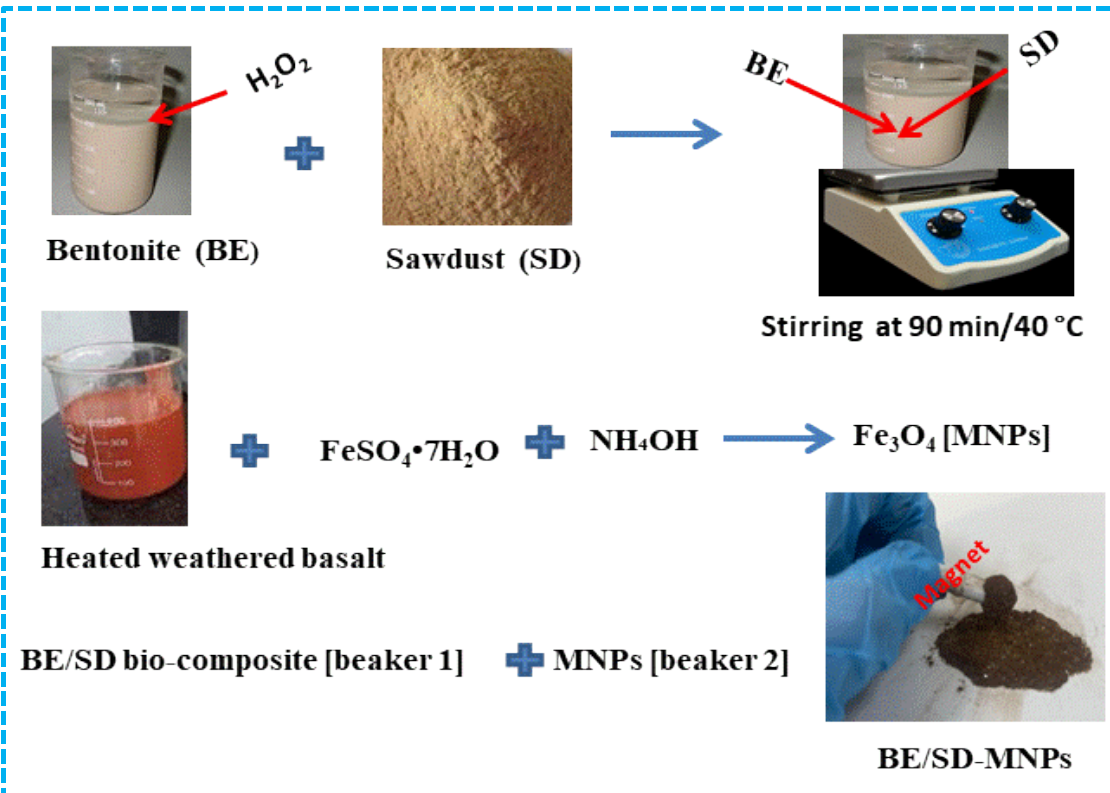
Figure 1. The schematic representation of BE/SD – MNPs composite the fabrication.